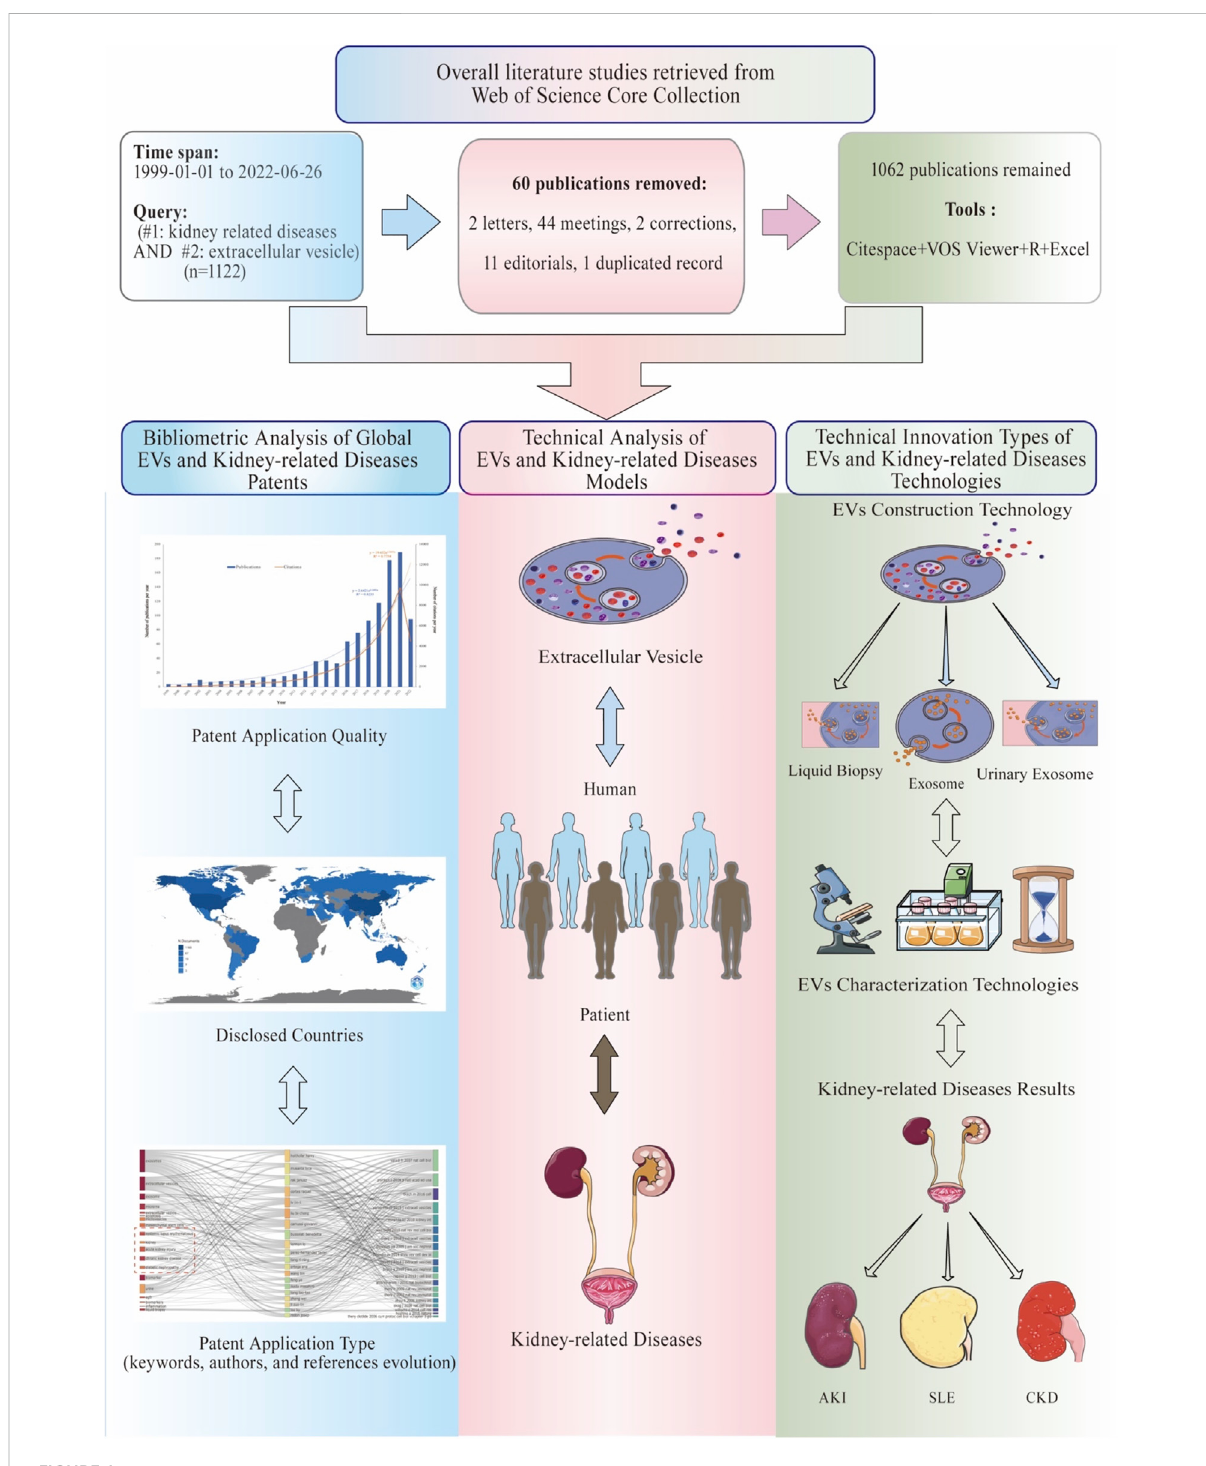
FIGURE 1 Flow diagram of the included publications, methods, and results of bibliometric